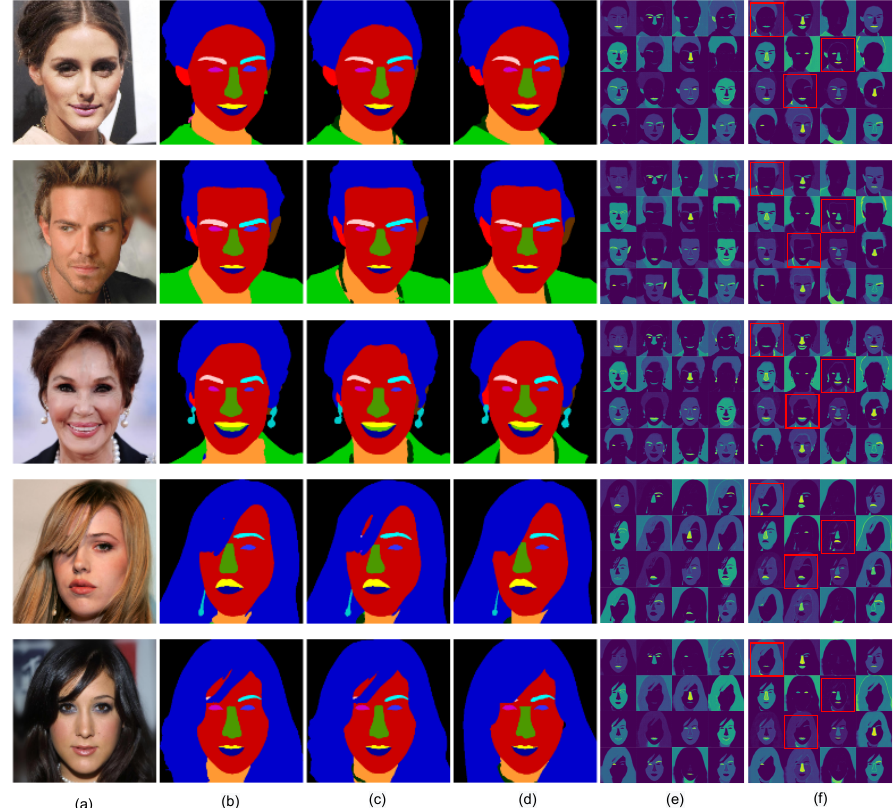
Figure 5. General image parsing results and feature activations on CelebAMask-HQ test set. ( a ): Original images. ( b ): Unet++ with Imagenet pretrained (baseline) parsing results. ( c ): Unet++ pretrained with the proposed self-supervised method. ( d ): Ground truth. ( e ): Encoder feature activation from baseline. ( f ): Encoder feature activation from ours. The baseline model obtains poor performance with necklace, and there is no necklace feature activation. The model pretrained with our methods shows better results. The first two rows even have better results than the ground truth. From the red box in the last columns, our pretraining method helps the model build necklace feature representation